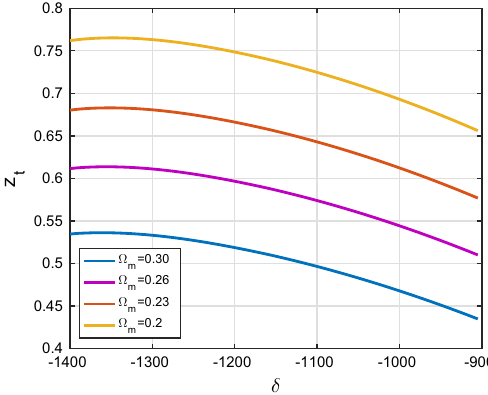
Fig. 3 Transitionredshift( z t )versus δ forsomevaluesof (cid:7) m whenever